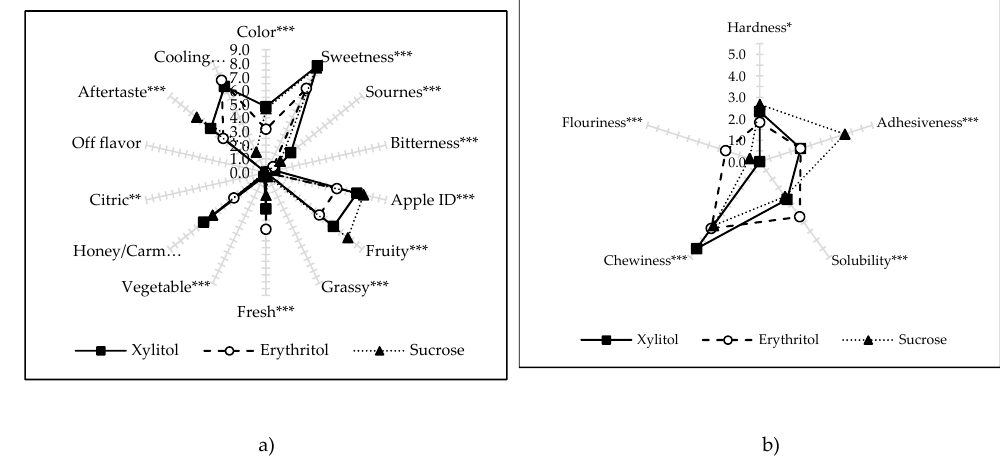
Figure 7. Descriptive sensory analysis of dried apples previously osmo-dehydrated in different solutions with ultrasound pre-treatment: attributes for appearance, basic taste, and flavor ( a ), texture attributes ( b ). *, ** and *** -- significant at p < 0.05, 0.01, and 0.001, respectively.